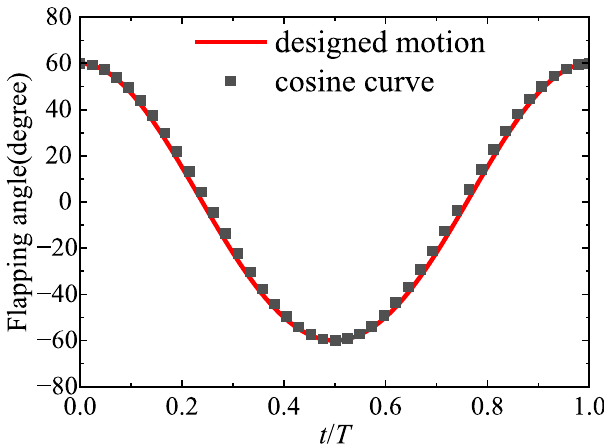
Figure 2. The designed output flapping angle of the mechanism compared with cosine curve. T is the flapping period, and t is the physics time. the flapping period, and t is the physics